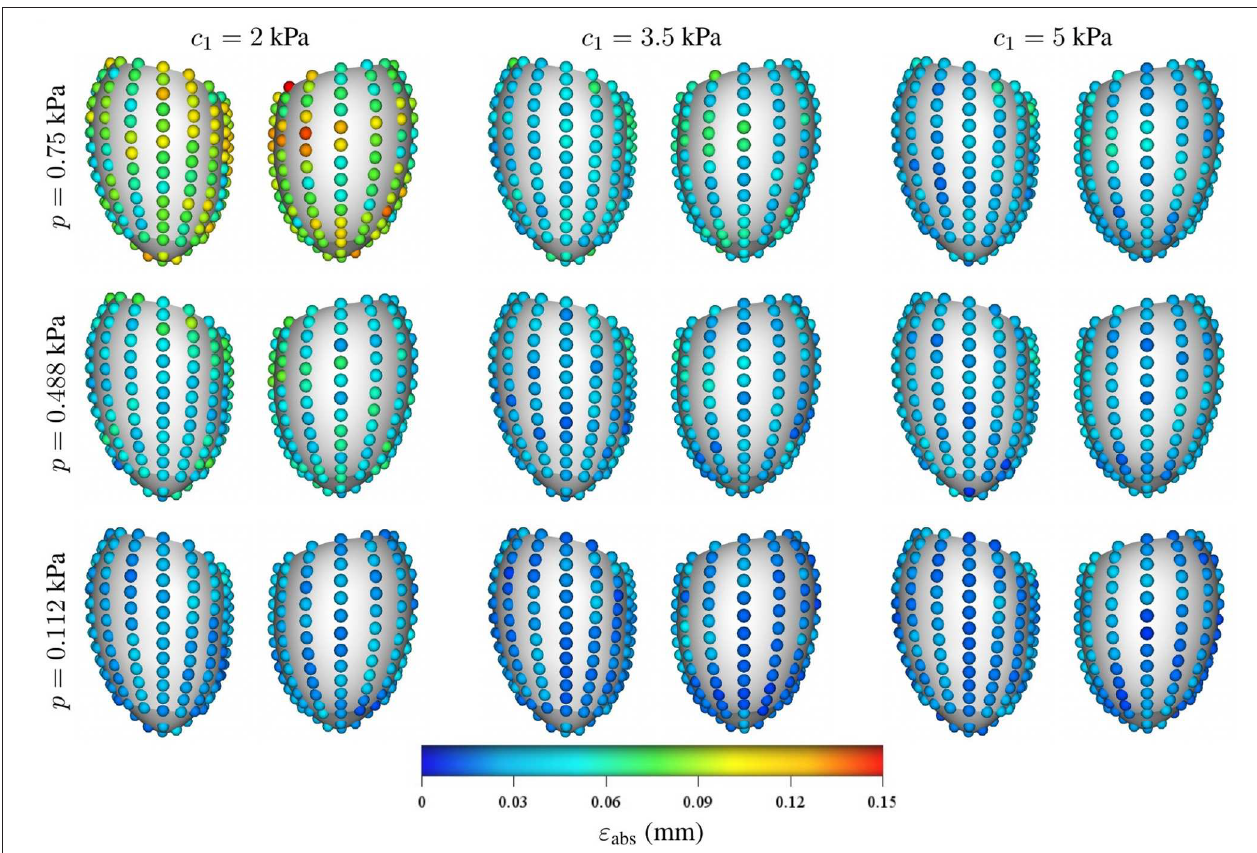
g 1 g 2 0 and 0 in the anterior and posterior views of the LV: ˆ ˆ = = 0.112, 0.488, and 0.75 kPa). =